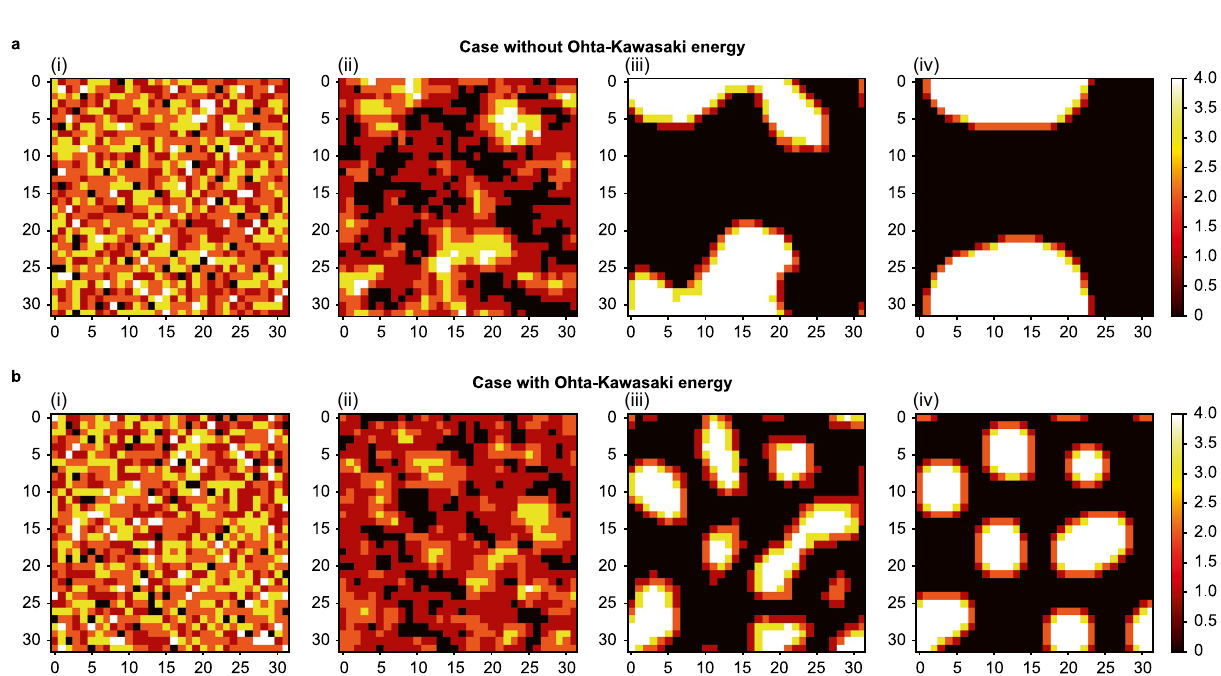
Figure 4. Temporal change until equilibrium is reached by the quantum annealing simulator in the case of f = 0.3 ( a ) without Ohta-Kawasaki energy and ( b ) with Ohta-Kawasaki energy. As for the results obtained by the conventional phase-field analysis, the stronger the Ohta-Kawasaki energy becomes, the finer the microstructure at the equilibrium state. Without Ohta-Kawasaki energy, all the microstructures equilibrate as two large